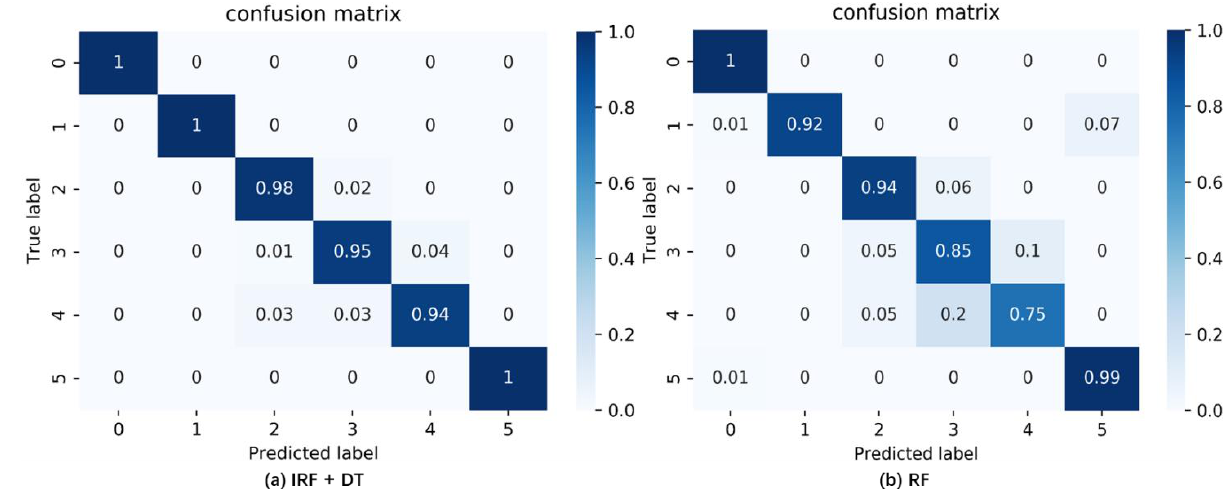
Figure 10. Confusion matrix for fault classification of automobile rear-axle assembly line: ( a ) IRF + DT algorithm; ( b ) RF algorithm.